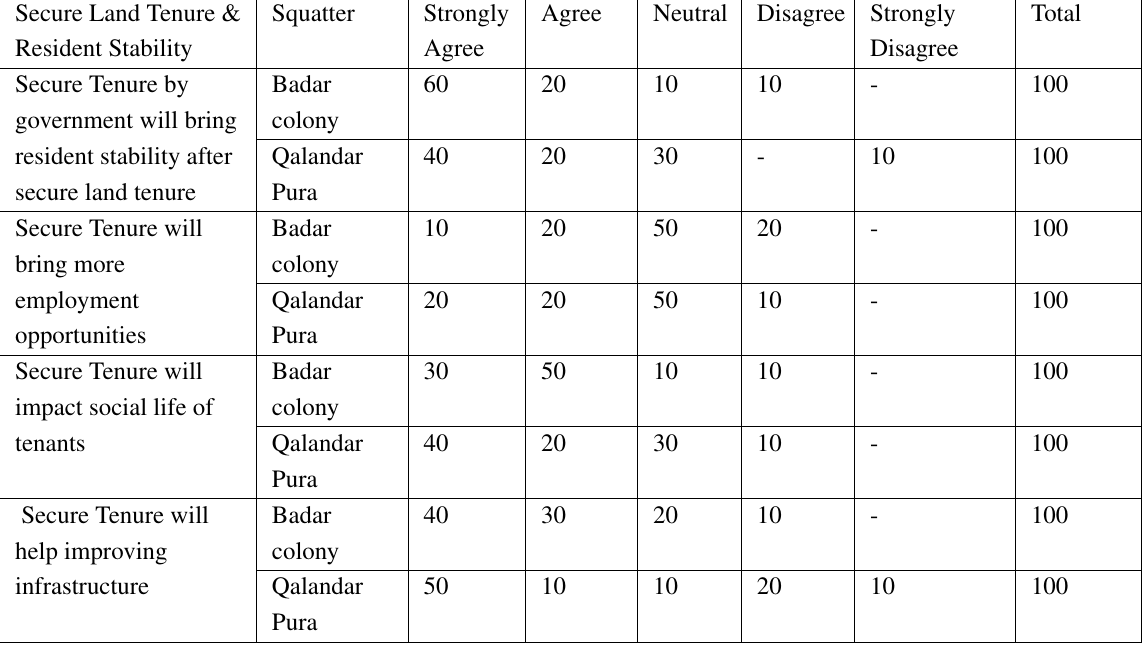
Table 6. Secure Land Tenure & Resident Stability in Sqautters, Source: